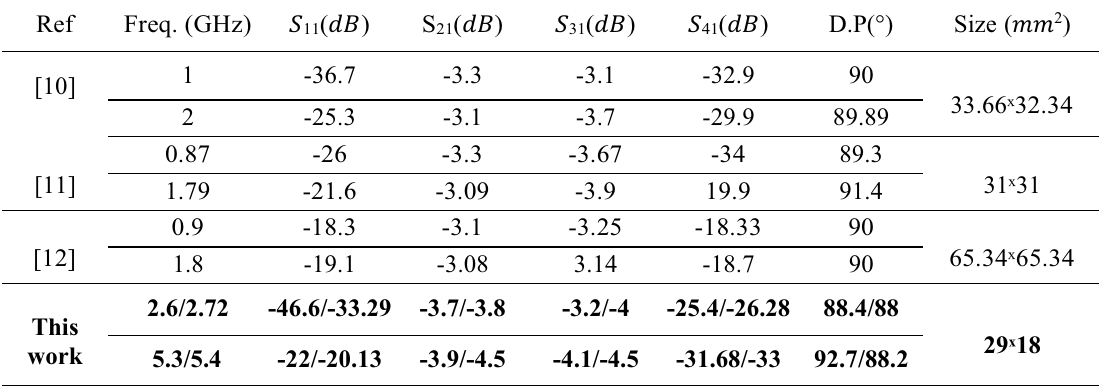
Table 4. Comparison between proposed coupler with previous